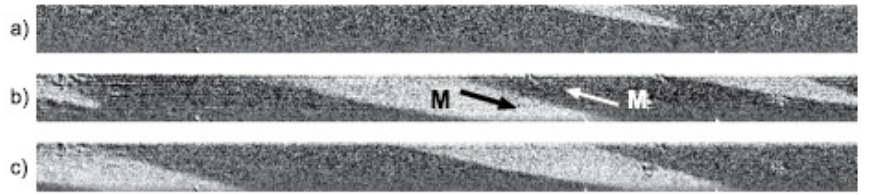
Figure 8. Nucleation and displacement of wedge-shaped domains along the curved surface of microwire in the presence of axial magnetic field. H ax : ( a ) 0.1 Oe, ( b ) 0.2 Oe and ( c ) 0.4 Oe. Reprinted with permission from [54].